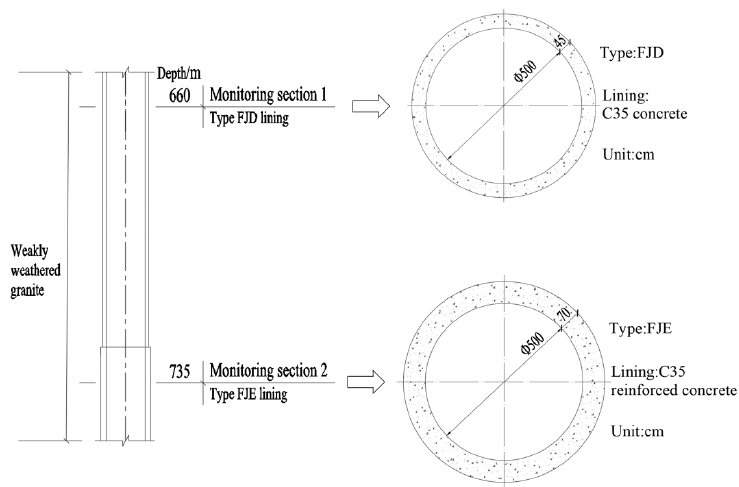
Figure 6. Monitoring section position and lining type.